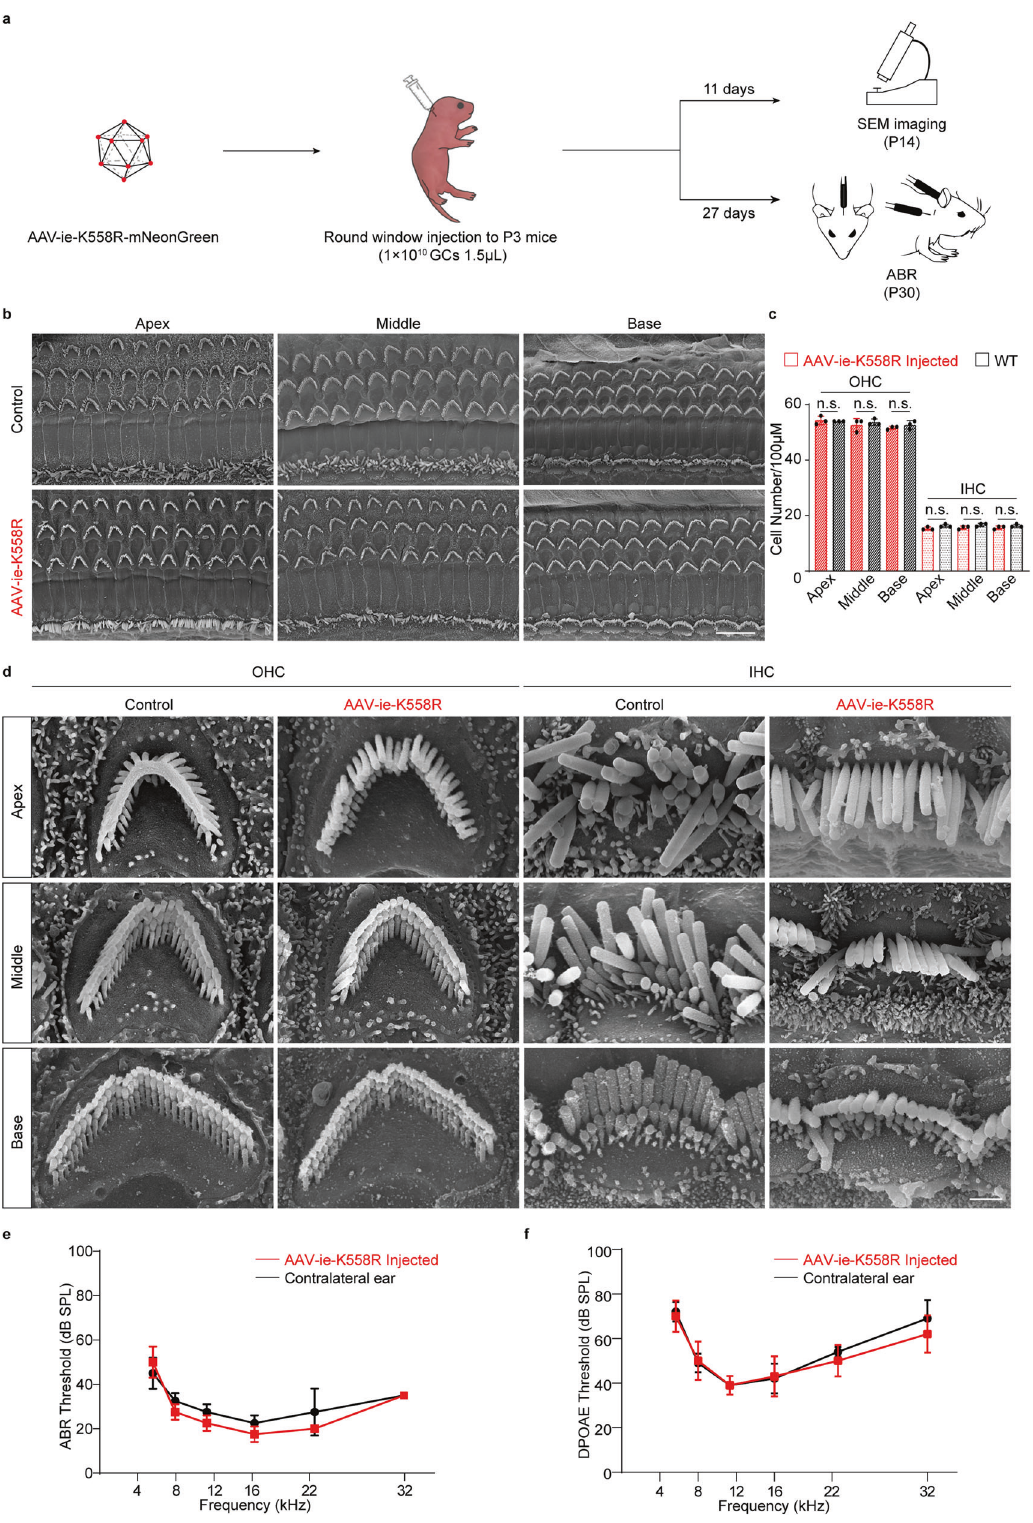
Fig. 2 AAV-ie-K558R is a safe vector. a Schematic experimental setup of AAV-ie-K558R study to investigate the vector safety. b Representative SEM images of WT control and AAV-ie-K558R-NLS-mNeonGreen-injected cochlea at apical, middle and basal region. Scale bar: 10 μ m. c OHCs and IHCs numbers per 100 μ m of uninjected WT mice and AAV-ie-K558R-NLS-mNeonGreen-injected cochlea at apical, middle and basal region. n = 3 mice. p Value is calculated by Student ’ s t test. n.s. refer to no signi fi cance. d Magni fi cation SEM images of outer hair cells (OHCs) and inner hair cells (IHCs) of P14 WT control and AAV-ie K558R-NLS-mNeonGreen-injected cochlea at apical, middle, and basal regions. Scale bar:1 μ m. e , f ABR and DPOAE thresholds of AAV-ie-K558R-NLS-mNeonGreen injected ear and un-injected contralateral ear on day 27 after virus injection at P3. Virus injection and the AAV vector show no effects on mice hearing